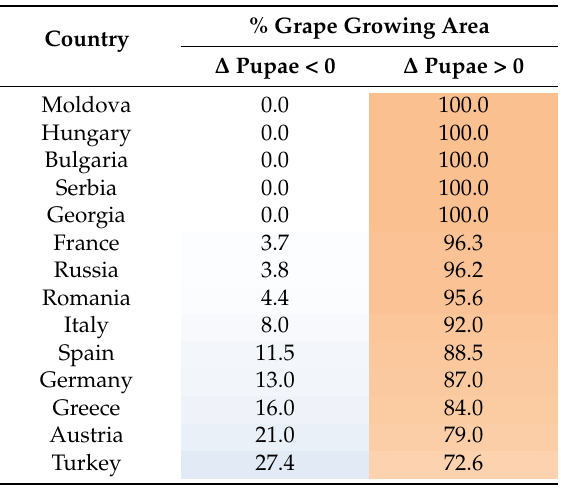
Table 2. Percent fraction (%) of the grape growing area where negative or positive changes in the density of grapevine moth ( Lobesia botrana ) ( ∆ pupae) are projected under an A1B scenario of 1.8 ◦ C average climate warming in the 18 Euro-Mediterranean countries with the largest vineyard